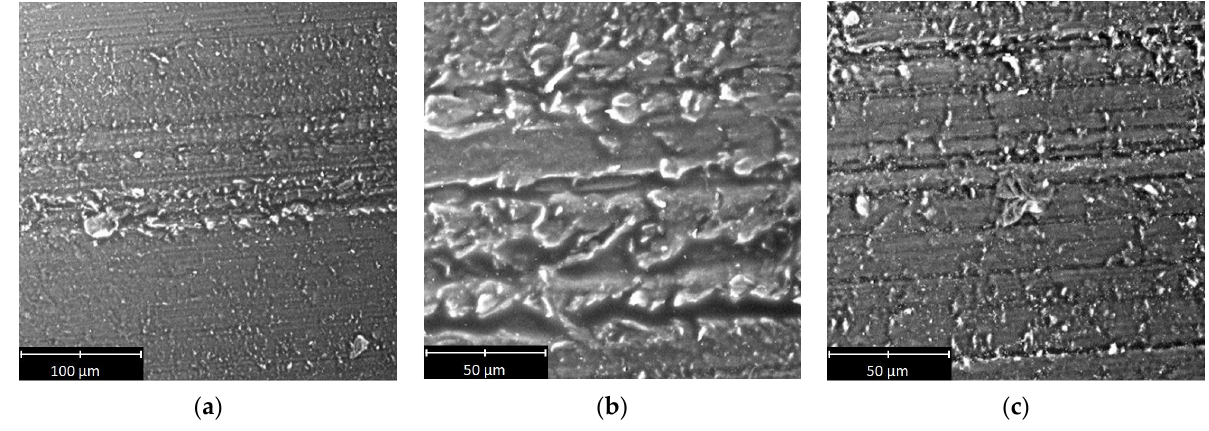
Figure 11. Selected SEM micrographs of sliding surface of PE-HD.